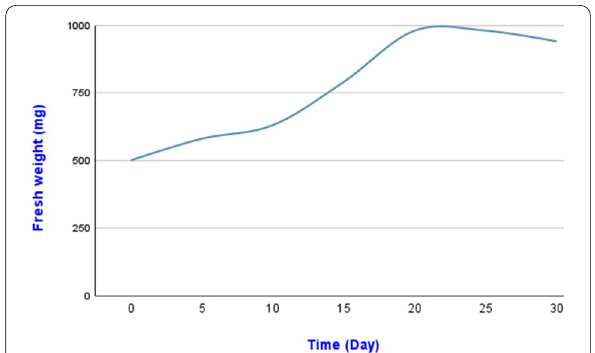
Fig. 3 Cell suspension growth curve of Gazania rigens based on measurement of fresh weight for 30